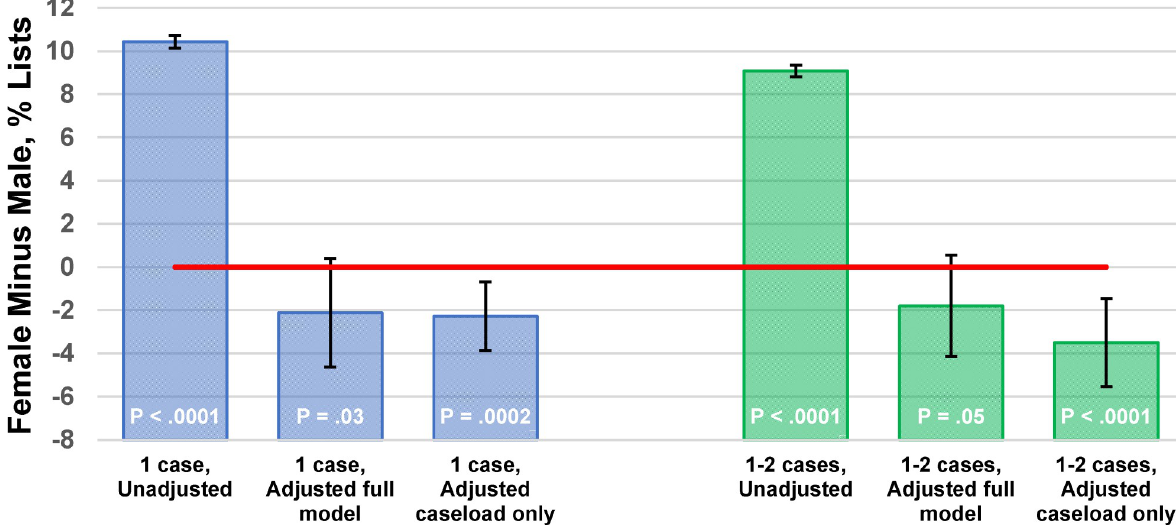
Fig 2. Predictive margins for difference between female surgeons and male surgeons in the percentages of lists of cases (same surgeon, day, and facility combination) with one case (blue) and with one or two cases (green). N = 1,509,190 lists. Error bars show two-sided 99% confidence intervals for the differences in these expected values. The Stata commands and output of these logistic regression models are in the supplemental content. The unadjusted models used gender alone as the independent variable, with robust variance estimation to be consistent with the other models. The full adjusted model included gender, decile of surgeon’s cases during the quarter, interaction between gender and caseload, surgeon’s specialty, and quarter (Tables 2 and 3), and was estimated with clustering by facility. The model with adjustment for quarterly operative caseload only excluded the interaction but was estimated with clustering by facility (Table 4). When estimated without clustering the point estimate was the same but the confidence intervals are narrower, ± 0.2% (Table 4). All variables other than gender were handled by using their average estimates over all observations. The figure shows that unadjusted differences between male and female surgeons vanishes when accounting for the effect of the confounding variables, most importantly caseload. See supplemental content for these averages.